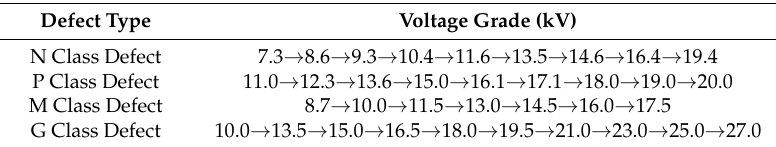
Table 1. PD experimental voltages.